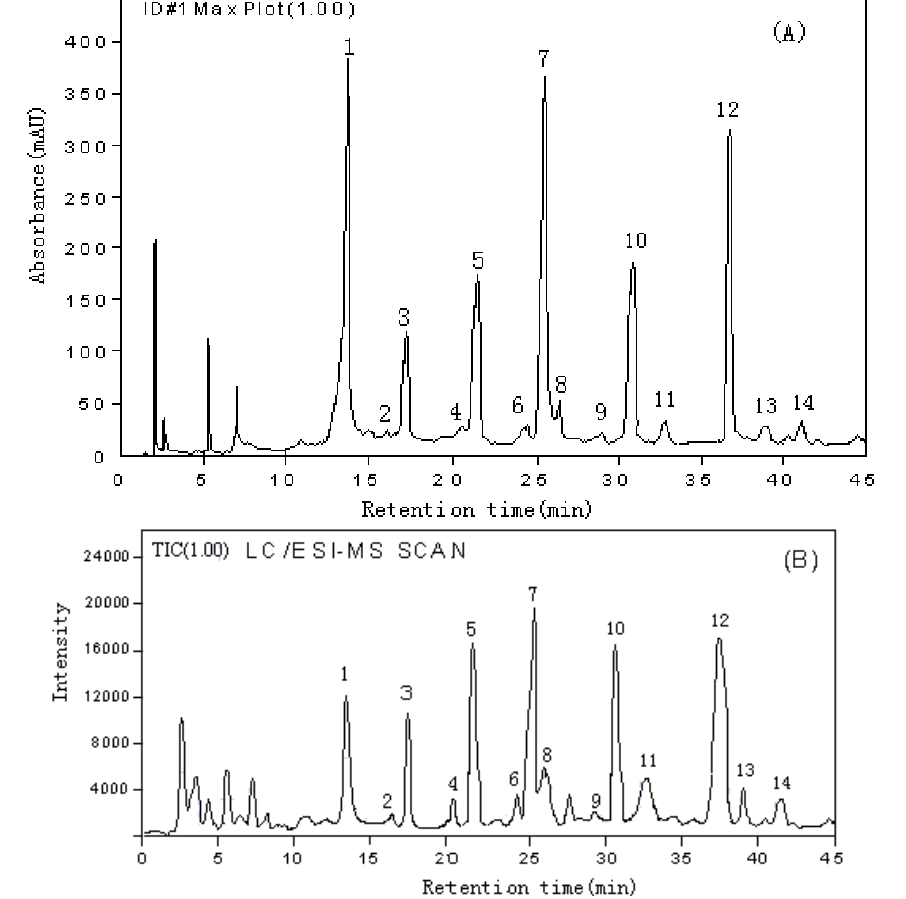
Figure 2. Simultaneous HPLC chromatogram detected with a diode array detector set at 260nm (A) and LC/ESI-MS total ion chromatograms (TIC) in scan mode (B) of A. mongholicus. Peak identification was listed in Table 2.